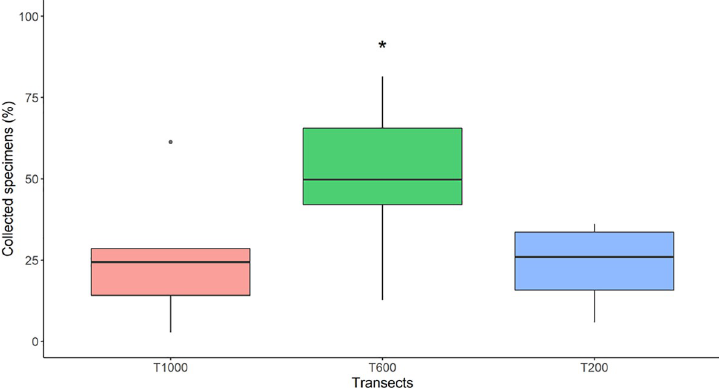
Fig 4. Relative abundance of collected specimens by transect. The figure shows the percentages of collected specimens by transect across sites and denotes a significantly higher sand fly abundance in the 600 m transect versus the other two transects. The dot on the 1,000 m transect denotes an